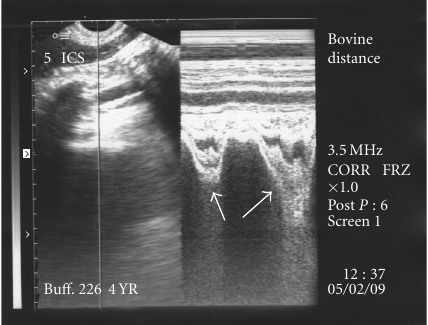
Figure 10: Reduced biphasic reticular motility (arrows) seen in the thoracic cavity on B+M mode